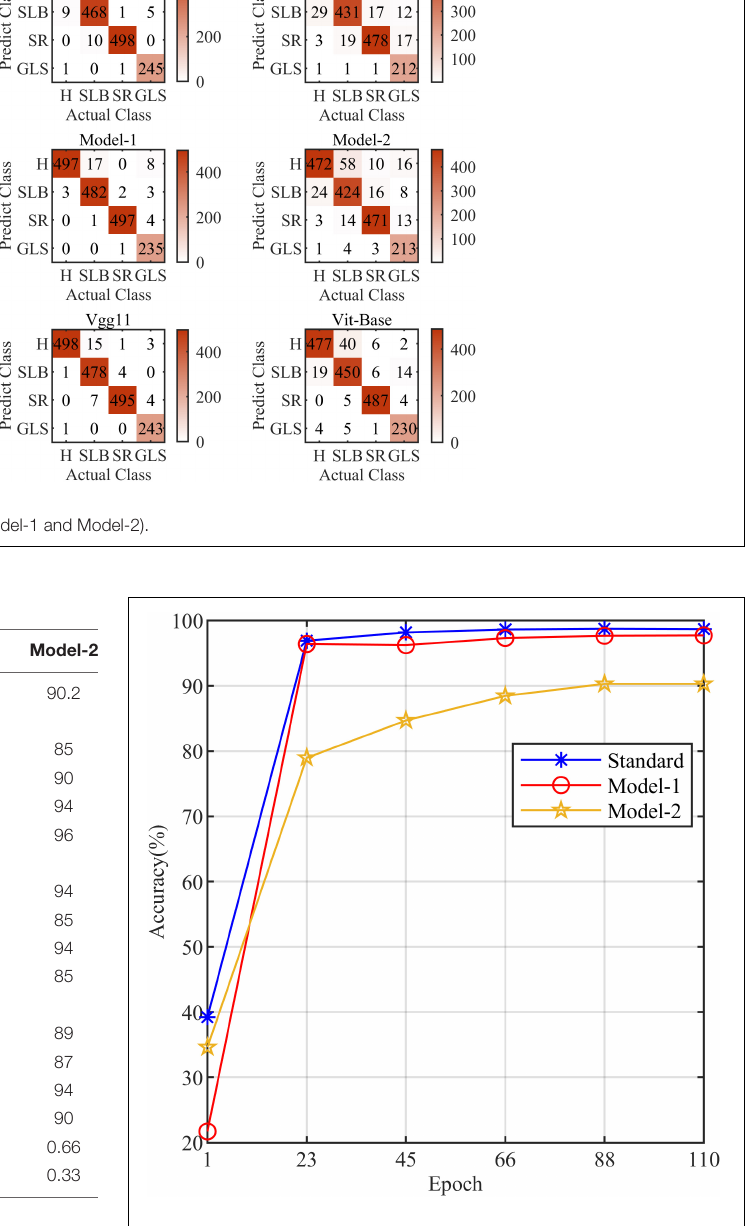
FIGURE 10 | The accuracy line chart of the standard model, Model-1, and